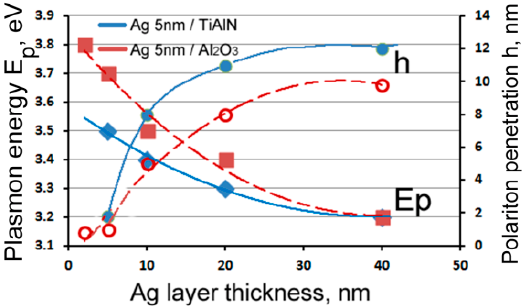
Figure 4. Energies of plasmon HREELS peaks Ep and depths of plasmon-polariton penetration at the metal/dielectric boundary δ SPP vs Ag nanolayers thickness.